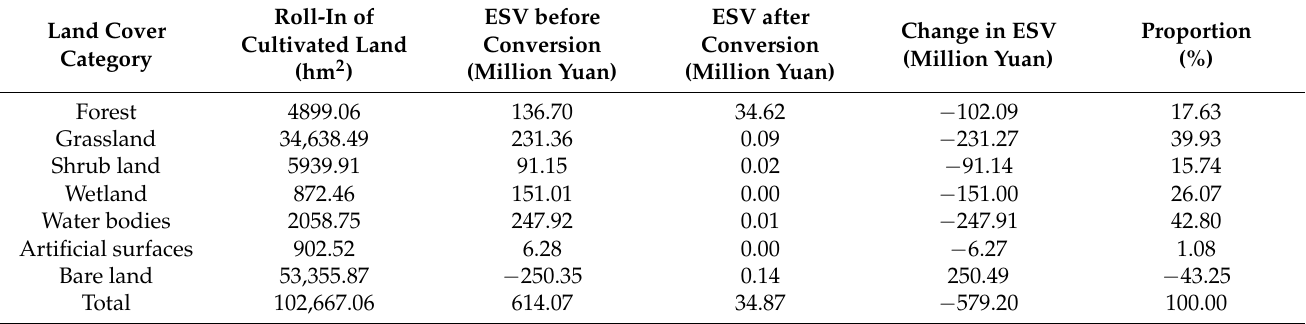
Table 6. The change in ESV caused by the change in cultivated land,